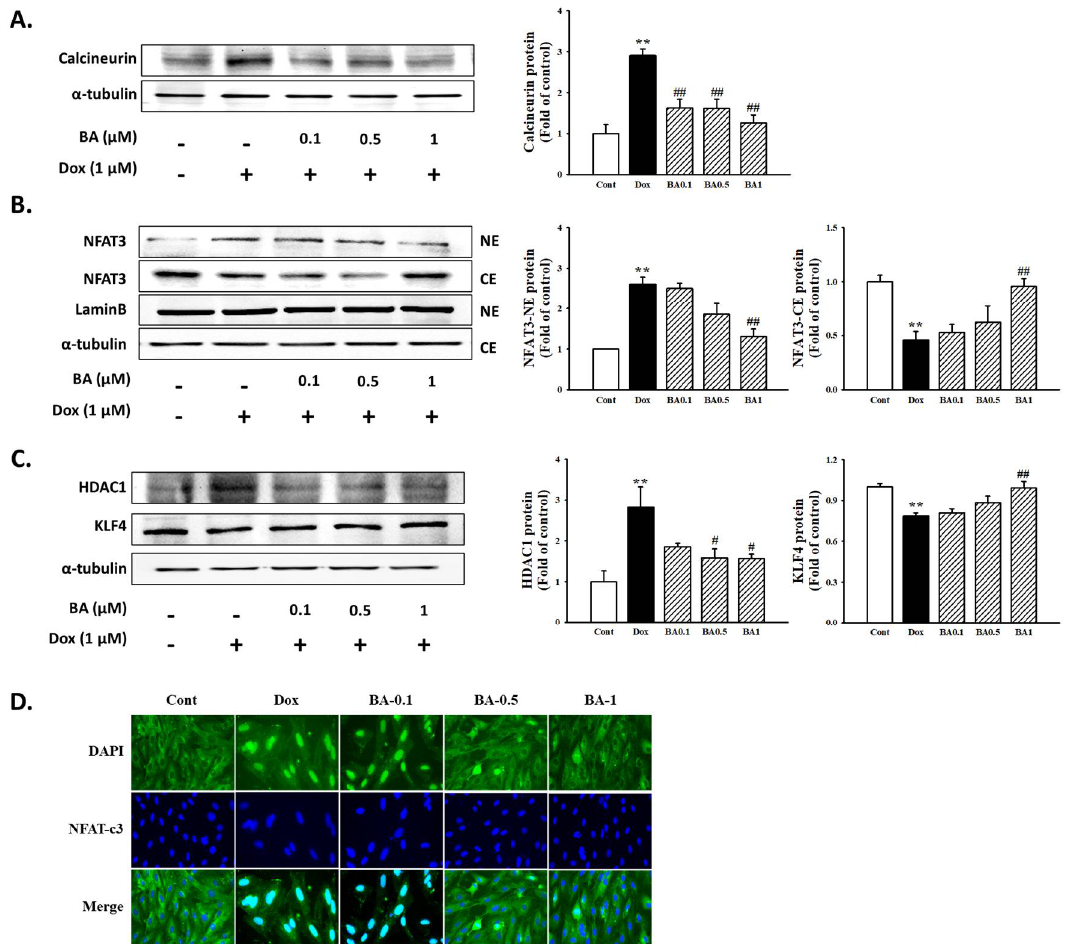
Figure 6. The effects of BA on calcineurin/NFAT-3 signaling pathway. Expression of calcineurin ( A ), nuclear localization of NFAT-3 ( B ), and HDAC1/KLF4 ( C ), were determined by Western blot analysis. ( D ) Nuclear translocation of NFAT was examined by immunofluorescence analysis (Immunofluorescence, 400 × ). The results are expressed as the mean ± SE values of three experiments. ** p < 0.01, vs. control; # p < 0.05, ## p < 0.01, vs. DOX-treated